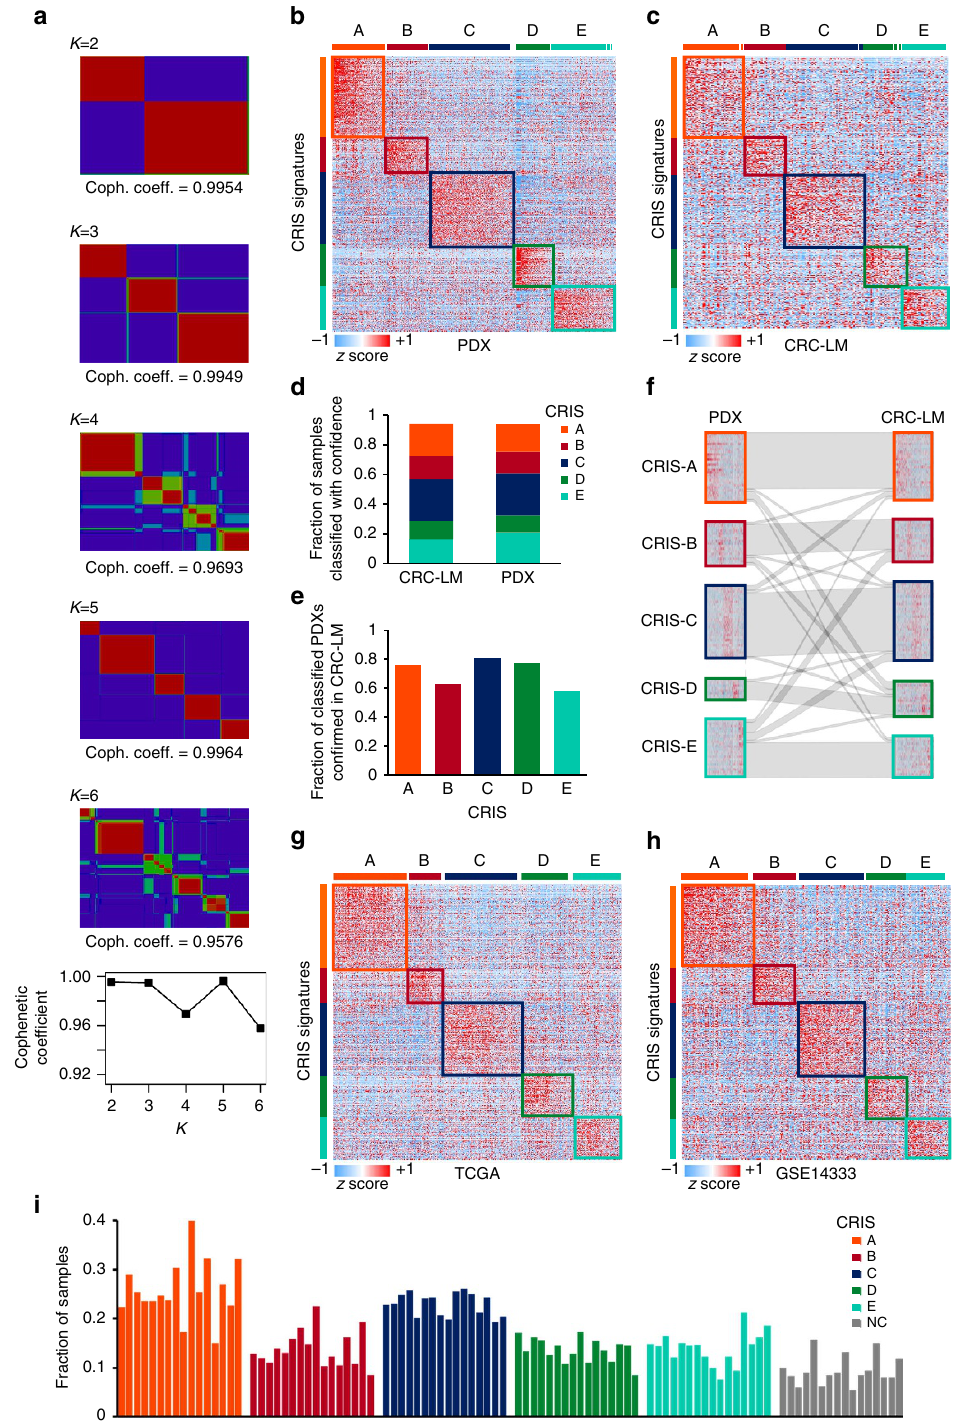
Figure 2 | CRIS classifies both CRC tumours and PDXs based on cancer-cell intrinsic transcriptional traits. ( a ) NMF-based consensus clustering of the PDX data set and plot of cophenetic coefficients for K ¼ 2–6. ( b , c ) Heatmap showing NTP-based CRIS classification of the PDX ( b ) and the CRC-LM ( c ) data sets. ( d ) Column chart showing the fractions of CRC-LMs and PDXs that were confidently classified (FDR o 0.2) by CRIS; coloured sub-columns represent the relative distribution of subtypes within each data set. ( e ) Column chart showing, for each CRIS subtype, the fractions of samples for which CRC-LMs and their corresponding PDXs were confidently assigned (FDR o 0.2) to the same class. ( f ) Caleydo view of CRIS correspondences between CRC-LM samples and their PDX counterparts. ( g , h ) Heatmaps showing CRIS classification of primary tumours based on RNAseq data from the TCGA ( g ) and Affymetrix microarray data of the GSE14333 data set ( h ). ( i ) Column chart showing the distribution of CRIS subtypes based on NTP classification across 16 independent CRC data sets (Supplementary Data 11); NC (non-classified) indicates samples for which NTP could not confidently assign any of the subtypes (FDR 4